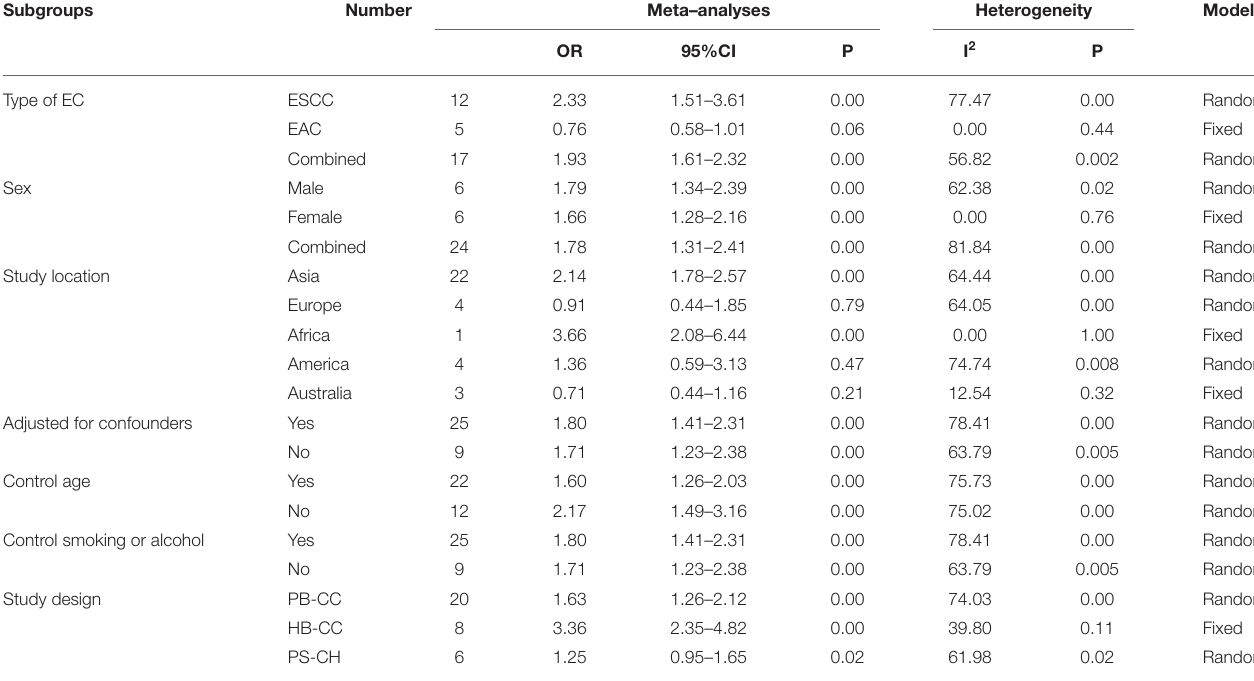
TABLE 2 | Subgroup analyses according to potential sources of heterogeneity.